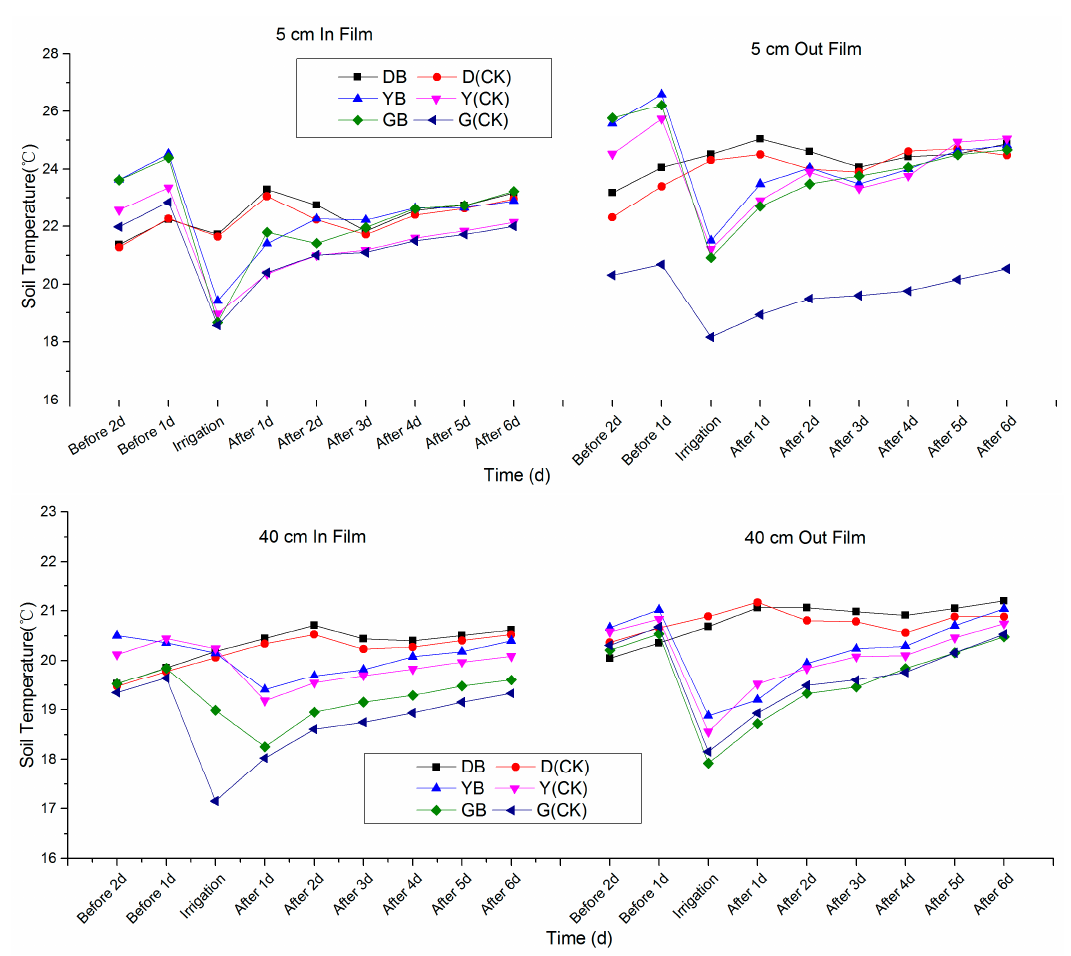
Figure 10. Effects of irrigation on soil temperature at different treatments and depths in 2017.